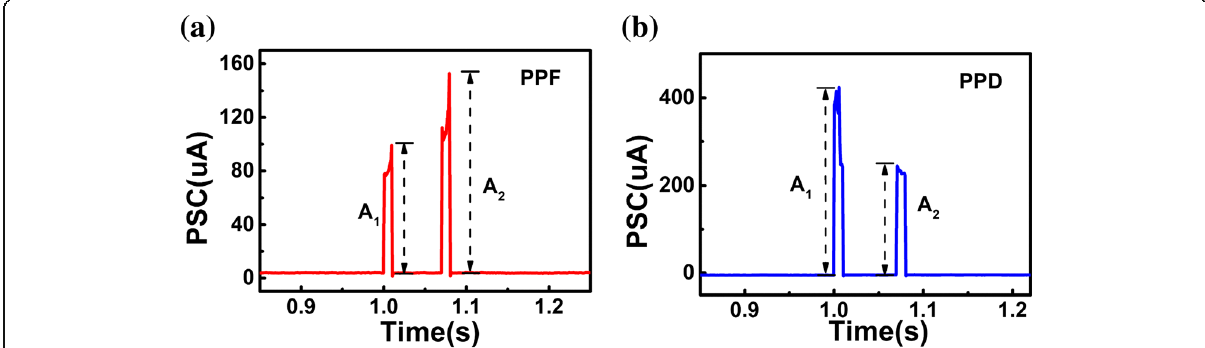
Fig. 5 a Typical PPF behavior induced by a pair of pre-synaptic spikes (2 V, 10 ms). b The PPD phenomenon of the artificial flexible synapse under inhibited spikes ( − 1 .5V, 10 ms)